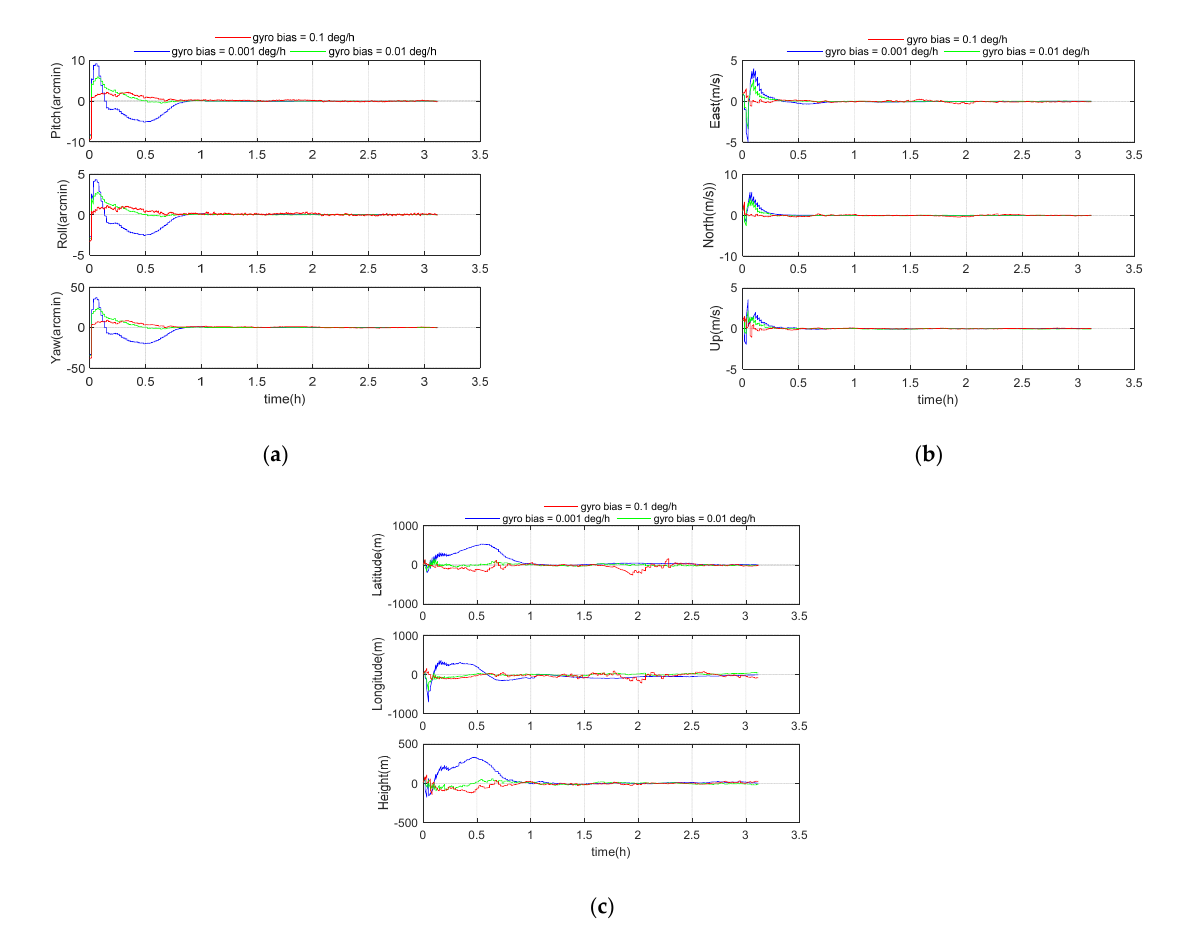
Figure 10. ( a ) Attitude error curve; ( b ) velocity error curve; ( c ) position error curve. Table 9. Simulation results of different inertial navigation levels.